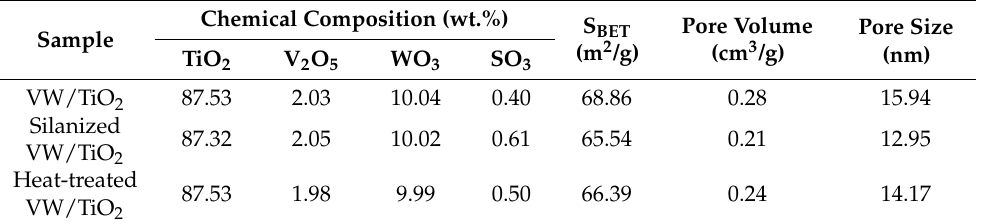
Table 1. X-ray fluorescence analysis and Brunauer-Emmet-Teller (BET) results of the V 2 O 5 -